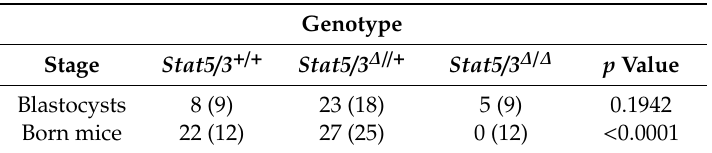
Table 2. Genotype distribution of Stat5 / 3 wt, heterozygote and homozygote animals. Number of embryos and pups from Stat5 / 3 ∆ /+ × Stat5 / 3 ∆ /+ breeding distributed accordingly to the genotype (expected number in brackets). Statistical di ff erences from the expected numbers were analysed with the chi-square test using GraphPad